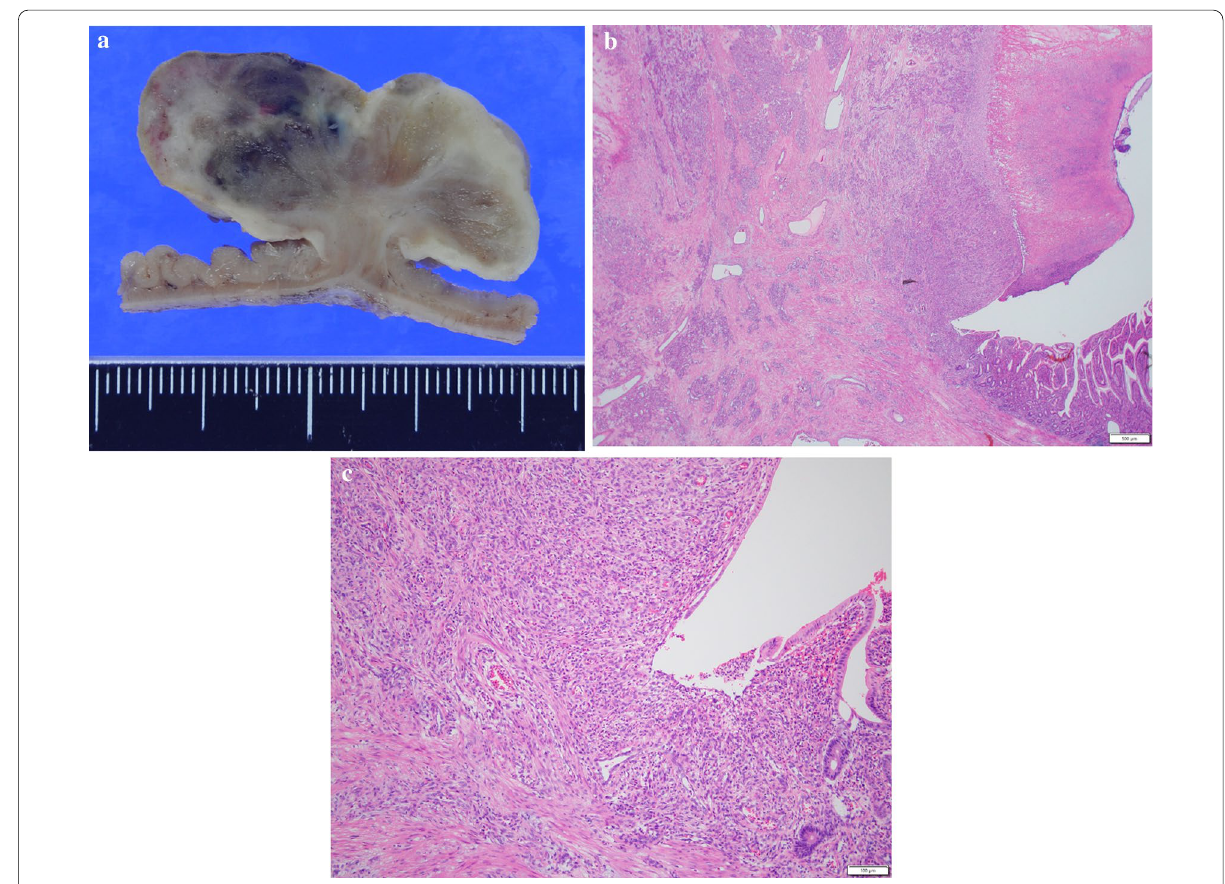
Fig. 4 Histological examination of the tumor. Macroscopically, a milky-whitish to grayish solid tumor, 4.2 semipedunculated polypoid structure in the ileum ( a ). Microscopically, it consists of lobulated lesions with capillary proliferation infiltrated with inflammatory cells, accompanied with erosive mucosa on its surface (hematoxylin and eosin [H&E] stain) ( b , c